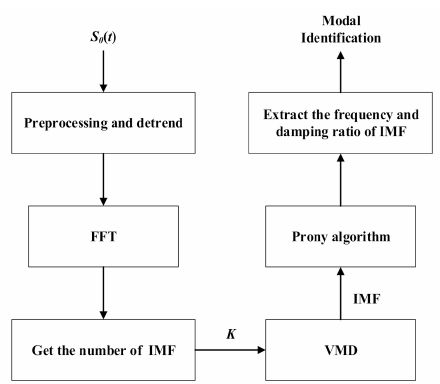
Figure 1. Framework of variational mode decomposition (VMD)-based oscillation identification from an ambient